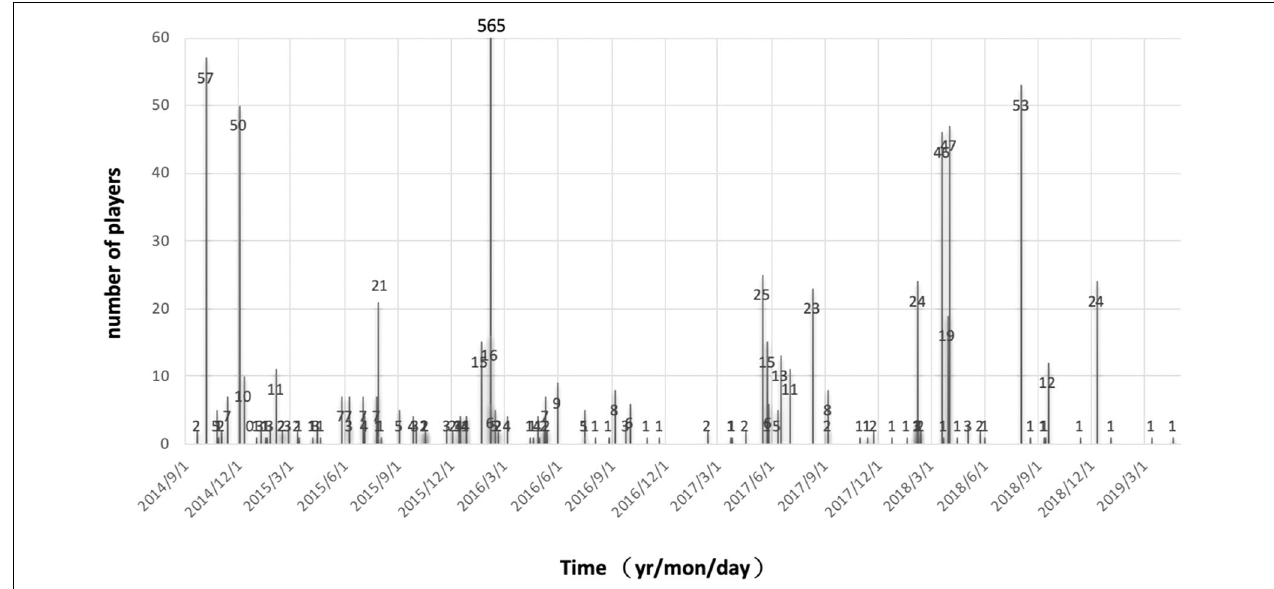
FIGURE 9 | Number of players for the ML ≥ 4 inland earthquakes since September 2014. For the 2016/2/6 Meinong earthquake, the number of volunteers reaches